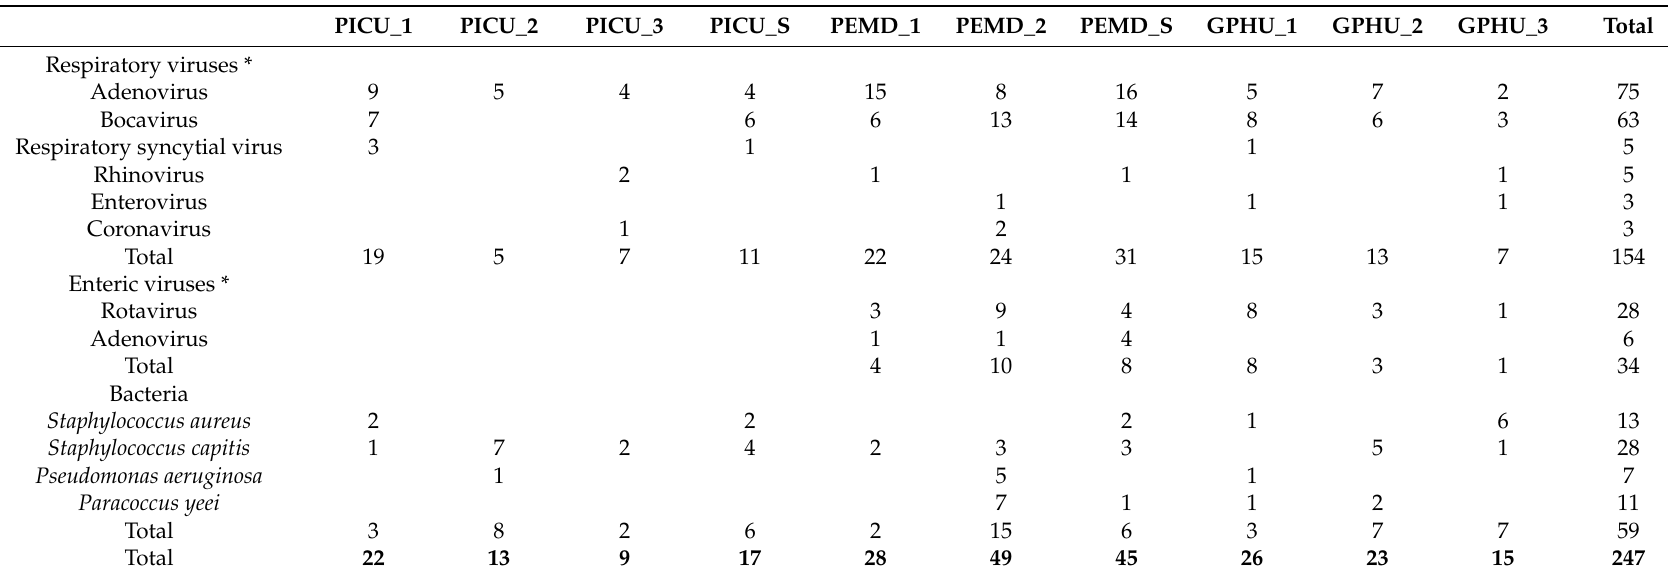
Table 1. Viruses and bacteria detected on voluntary paediatrician’s mobile phones (MPs) for 23 weeks in the University Hospital of Saint-Etienne. Number of positive samples among the total of 230 ones performed along the 23 weeks of the study. The MPs were named according to the department they were used: paediatric intensive care unit (PICU), paediatric emergency department (PEMD) or general paediatric hospitalization unit (GPHU). MPs numbered 1 to 8 were nominative ones; PICU_S and PEMD_S were shared by all on-call